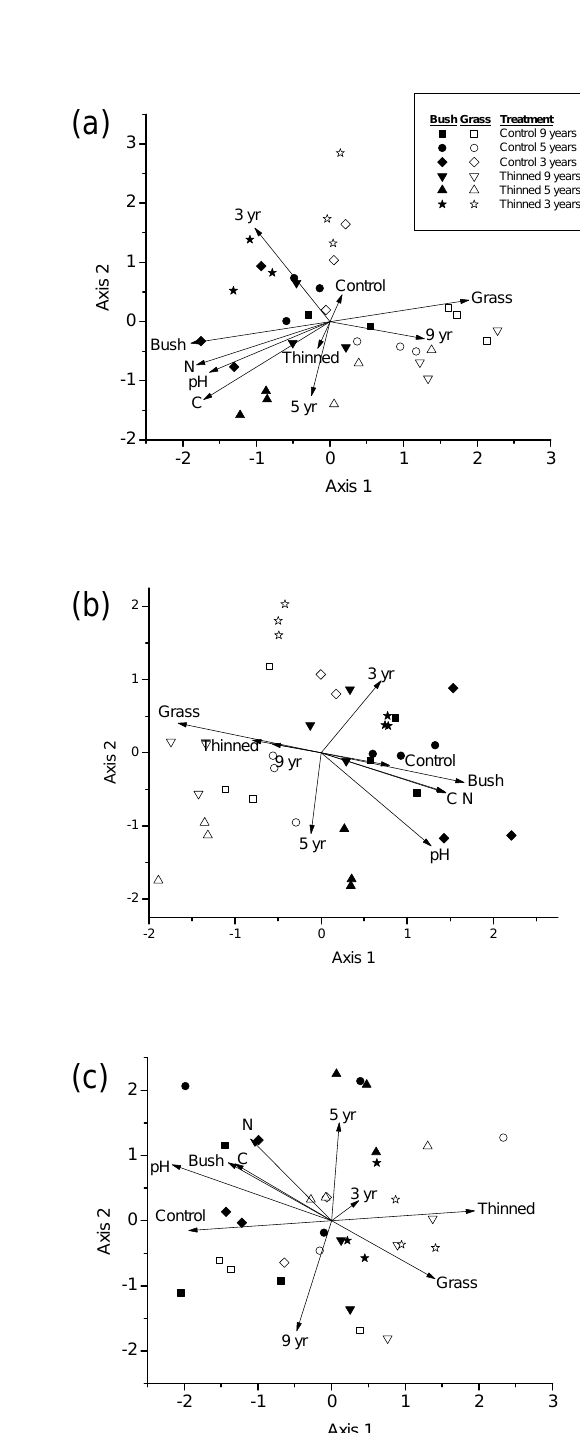
Figure 6. Canonical correspondence analysis of fungal TRFLP. (a) May 2012. (b) August 2012. (c) November 2013. Vectors in- dicate the correlations between each factor and the axes. Very small vectors were eliminated for the sake of